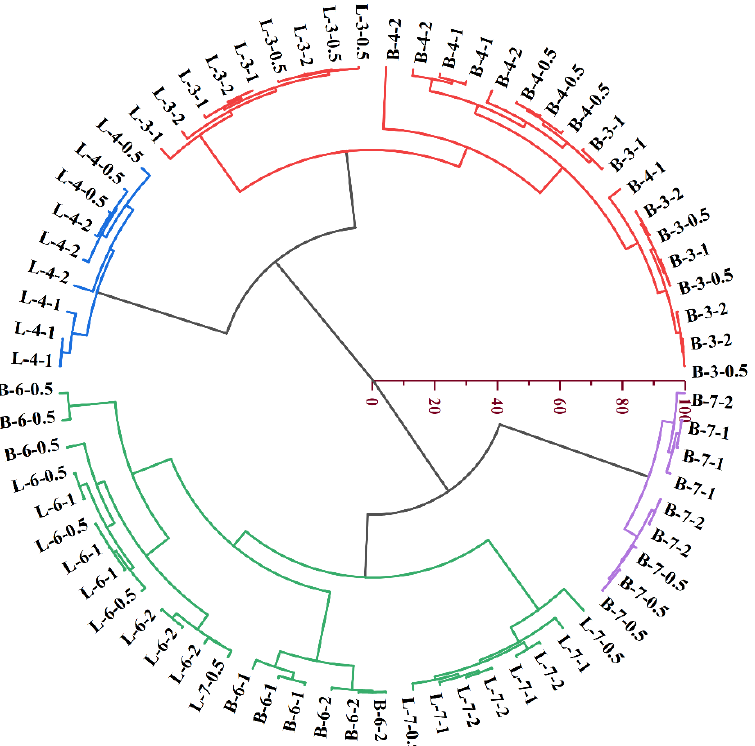
Figure 3. Illustrates that 24 types of manufactured biochar (three replicates for each biochar type)